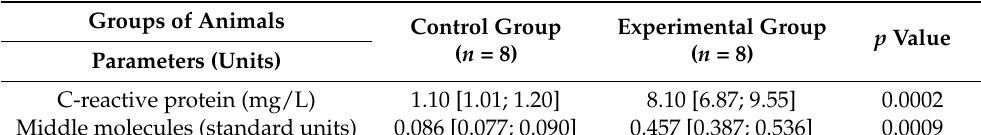
Table 1. Circulating inflammatory biomarkers in rats orally exposed to the common food additive E407a (Me [IQR]).